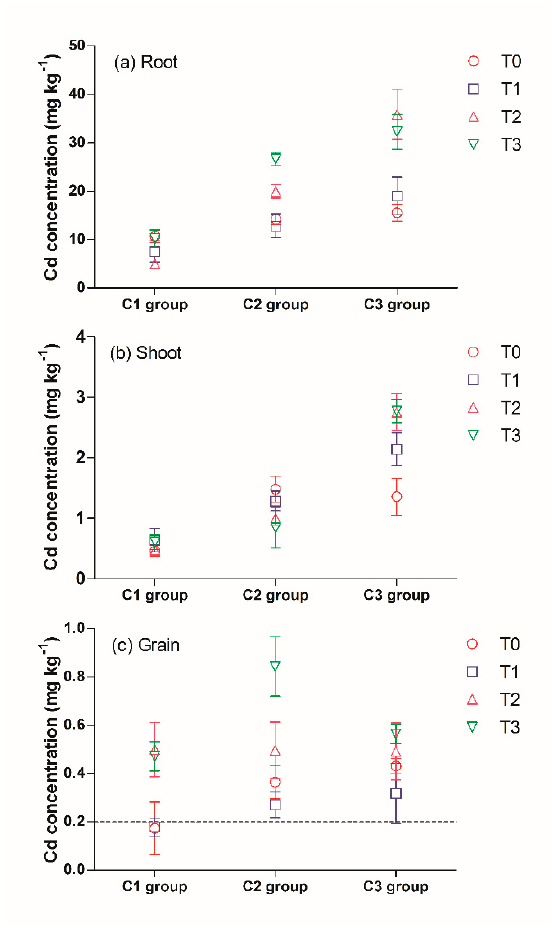
Figure 5. Cd content in different parts of plant: ( a ) roots, ( b )shoots, ( c ) grain. ----: threshold of Cd content in rice grain, China (GB2762-2012).